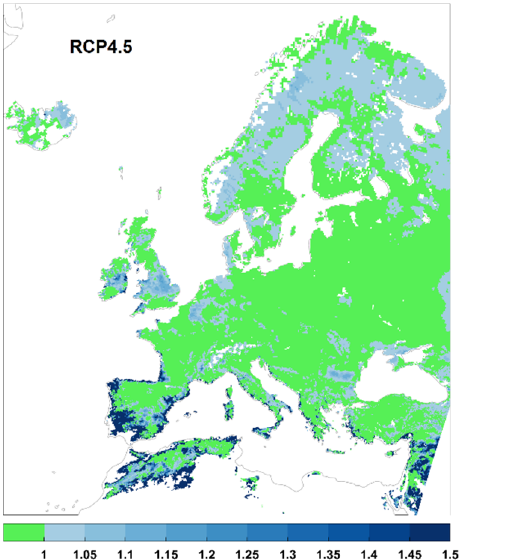
Figure 6. Mode of quartile ( a ) and frequency of the mode map and histogram ( b ) among the 18 different projections of expected changes in characteristic ground snow loads in the time window 2011–2050 with respect to 1951–1990. In ( b ) red areas in the map indicate lower intermodel agreement and higher uncertainty while blue areas indicate higher agreement and lower uncertainty. The histogram is drawn for the frequency of the mode considering the number of cells as % of the total in the EUR-11 domain.